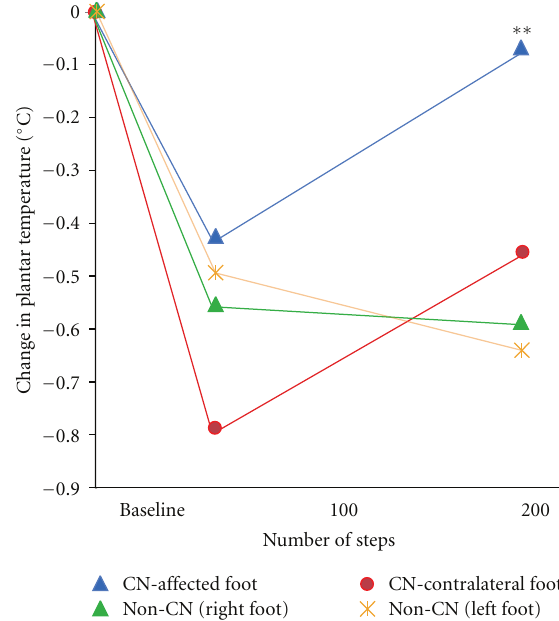
Figure 3: Change in plantar temperature as a function of walking steps for the hot spots recognized in the midfoot